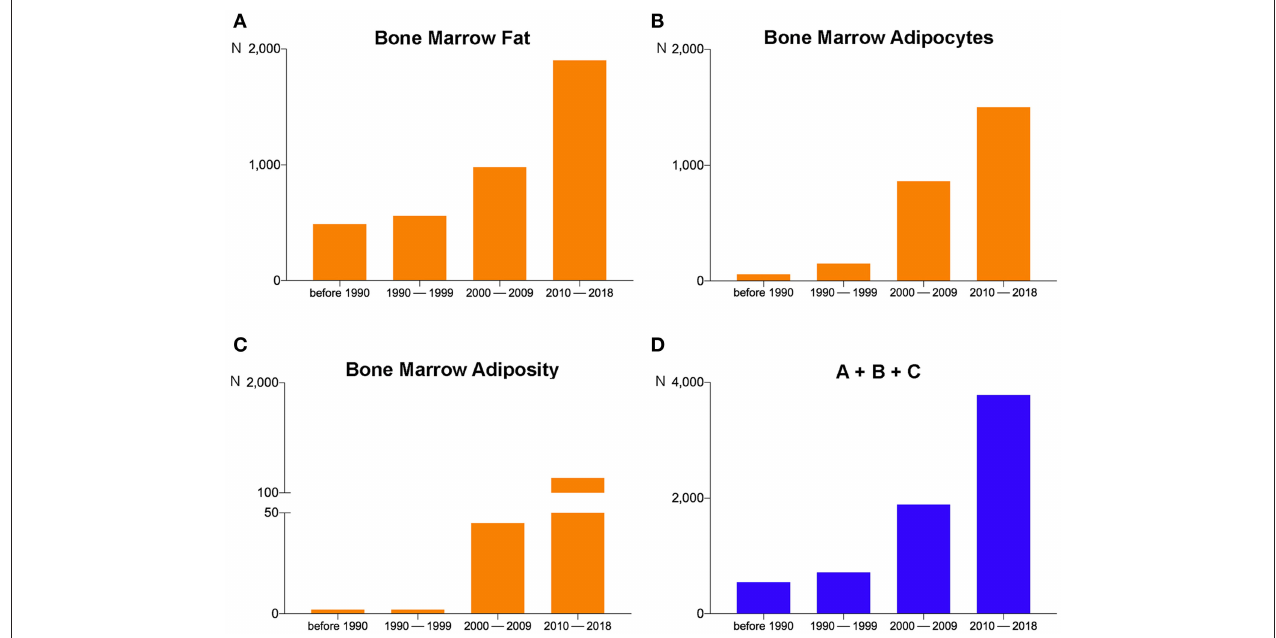
FIGURE 1 | Pubmed search results on September 10, 2018 for (A) “Bone Marrow Fat,” (B) “Bone Marrow Adipocytes,” and (C) “Bone Marrow Adiposity” revealed 3,929, 2,571, and 428 items, respectively. For each search, the period from 2010–2018 contains the largest number of items. (D) The sum of the items obtained by the three different searches (A + B + C). The number of the total items in 2010–2018 has grown by about 100%, 500%, and 700%, respectively, compared to 2000–2009, 1990–1999, and before